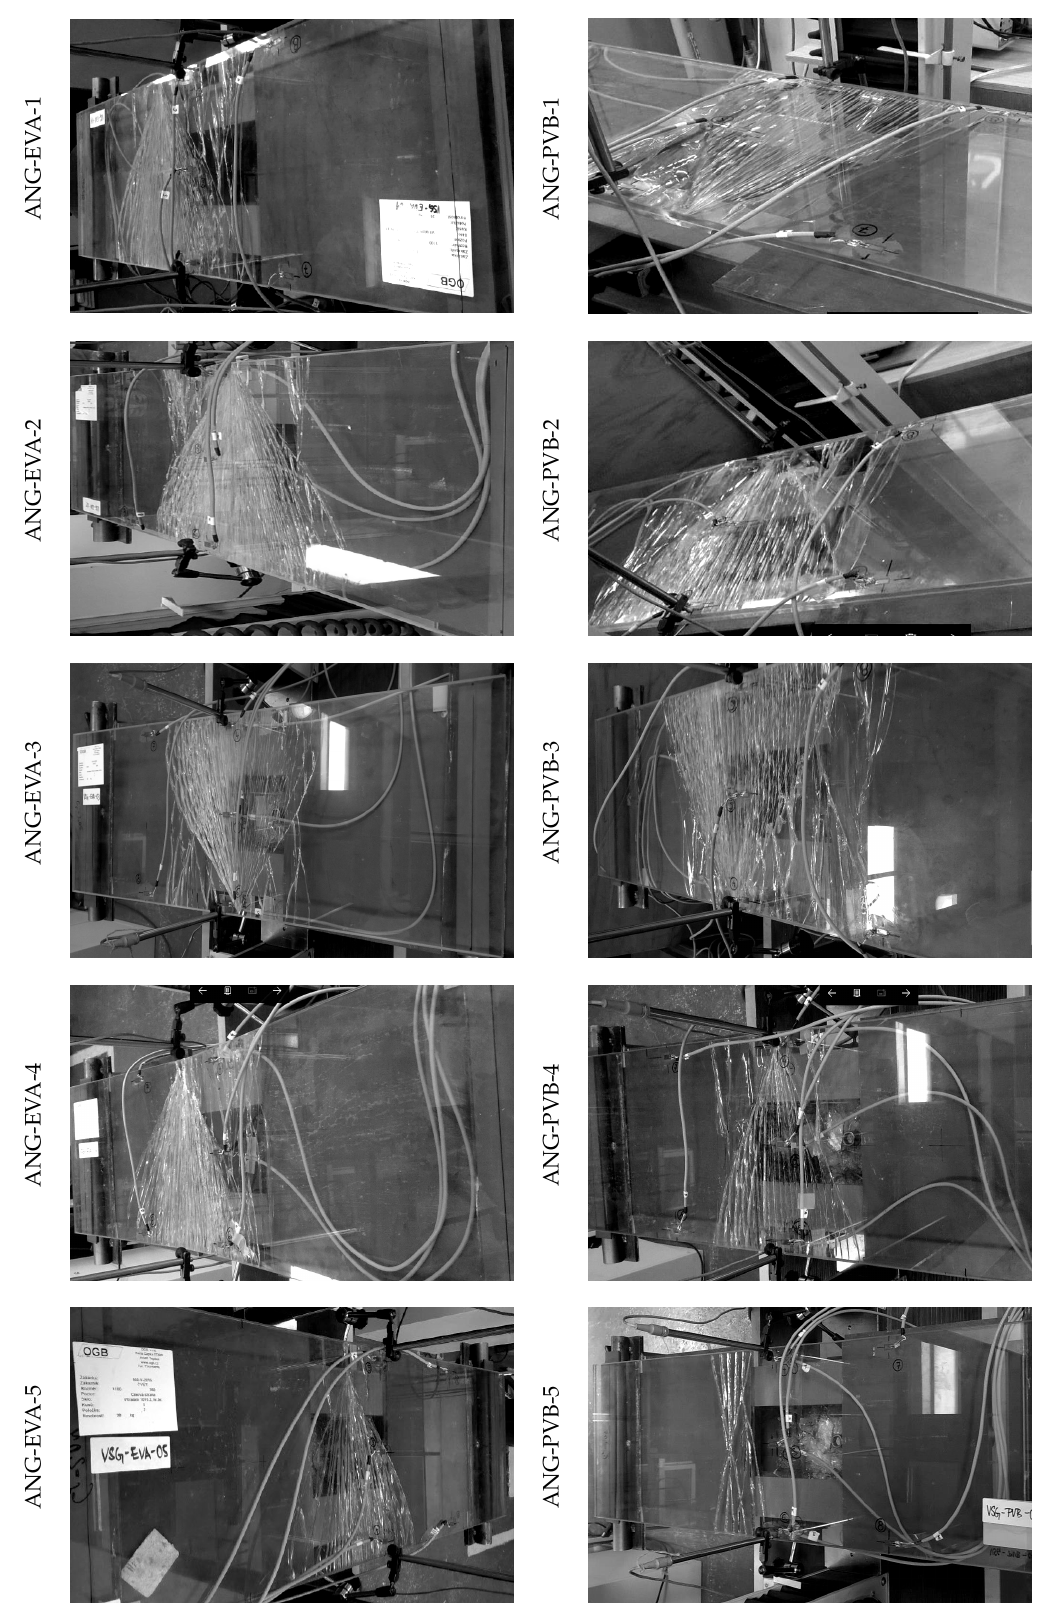
Figure 14. Fracture pattern after first loading for laminated glass samples. Both glass layers were damaged for ANG-EVA-4, whereas the fracture patterns for the other samples correspond only to the fracture of the bottom glass layer; courtesy of Tomáš Hána from CTU in